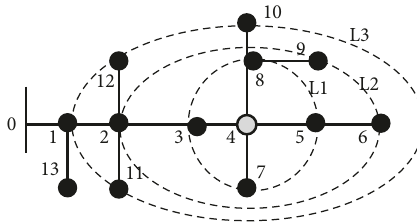
Figure 1: Schematic of island